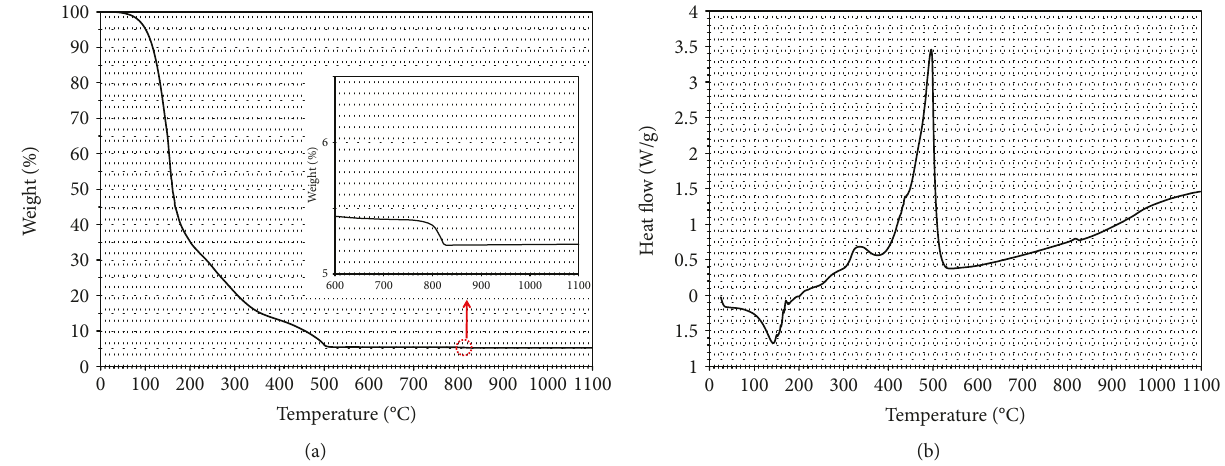
Figure 2: TGA-DTA analysis of the nanoparticle precursor gel (heating rate 5 ° C/min in air).